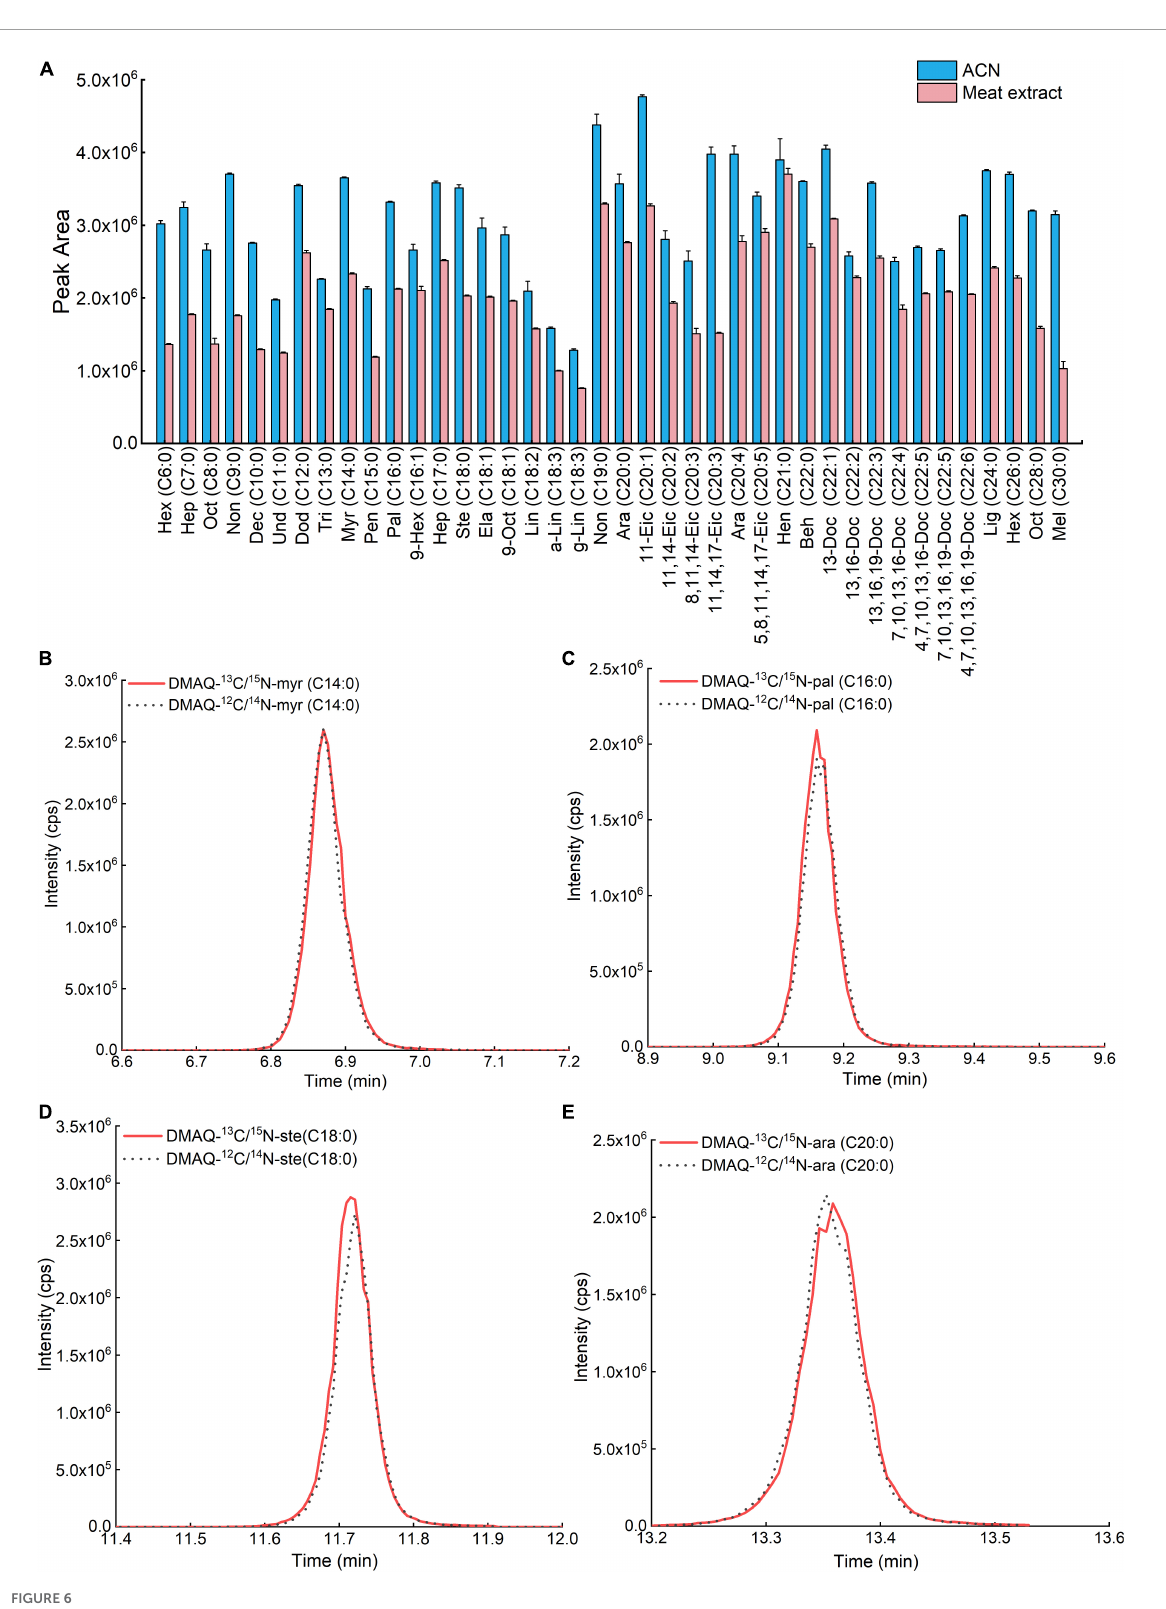
Frontiers in Nutrition